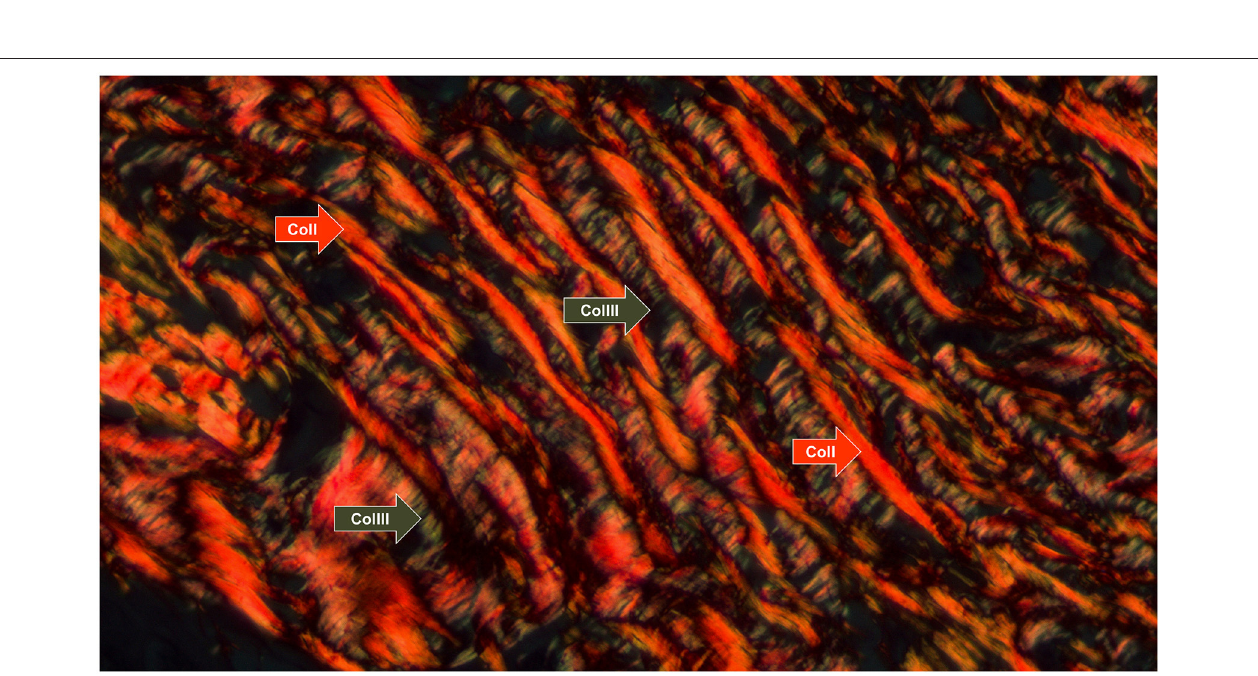
FIGURE 3 | Collagen fiber patterns I and III stained with picrosirius red and observed under polarized light. Type I fibers (thick and reddish fibers) and type III (thin and greenish fibers) are indicated by the arrows (red and green, respectively) (Picrosirius under polarized light, 630x).